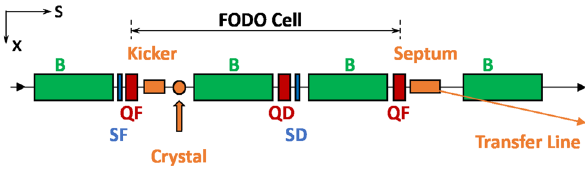
Fig. 4 Scheme of the beam extraction into the former DORIS transfer line. The extraction is embedded in the DESY FODO lattice consist- ing of dipoles (B) and focusing/defocusing quadrupoles (QF/QD). In addition, the two sextupole families (SF/SD) are indicated. The